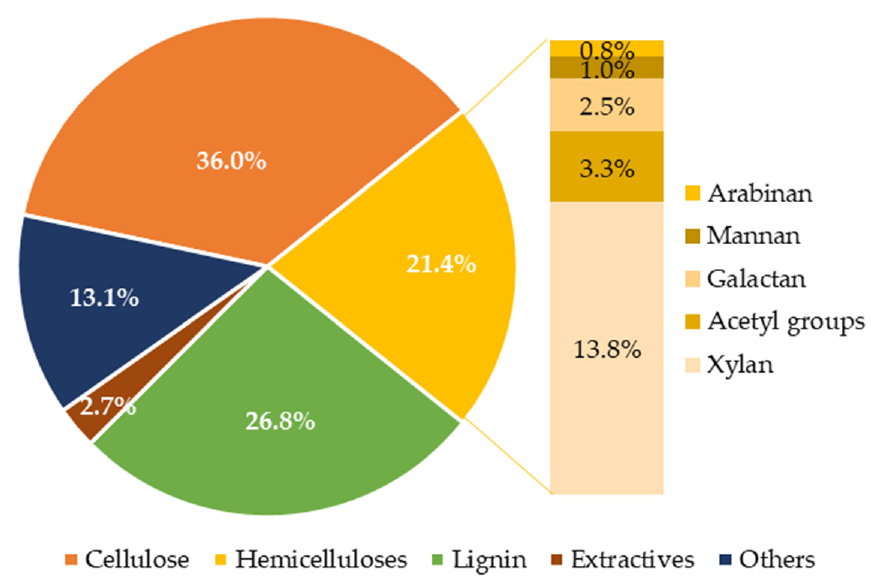
Figure 3. Average composition of water-extracted vine shoots, expressed as g of component per Figure 3. Average c omposition of water-extracted vine shoots, expressed as g of component per 100 100 g oven-dried material. g oven-dried material.